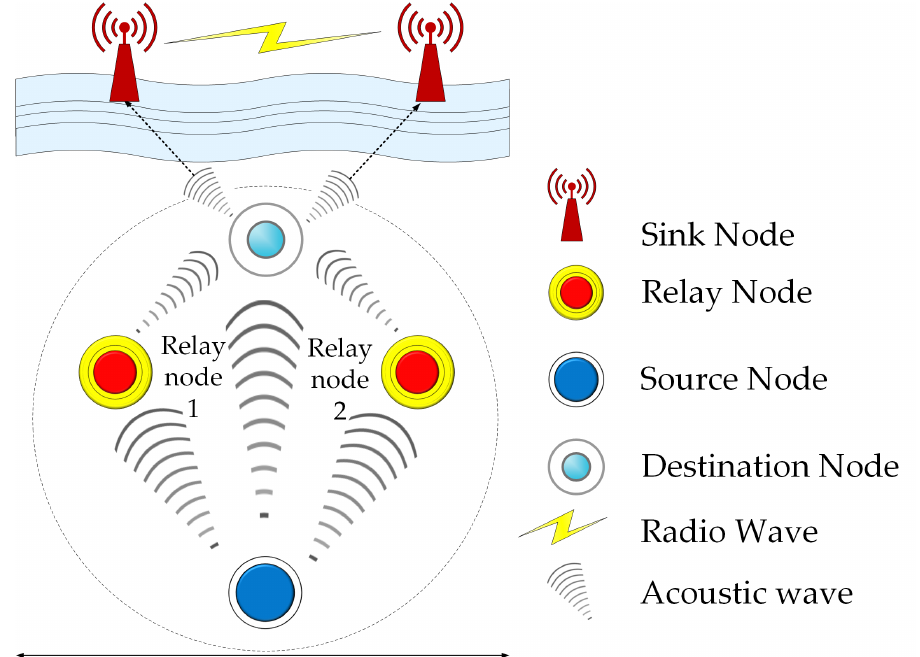
Figure 9. Cooperation of relay